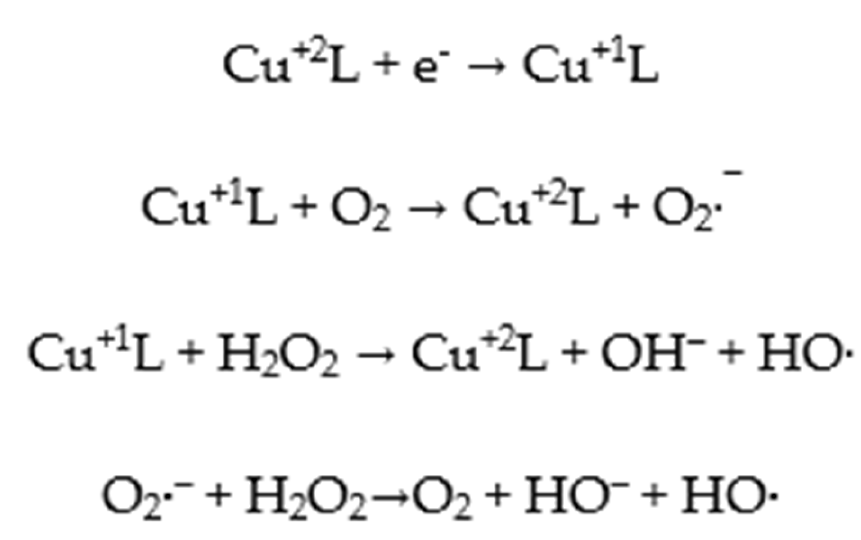
Figure 11. Possible ROS reactions in C1 and C2 complexes.